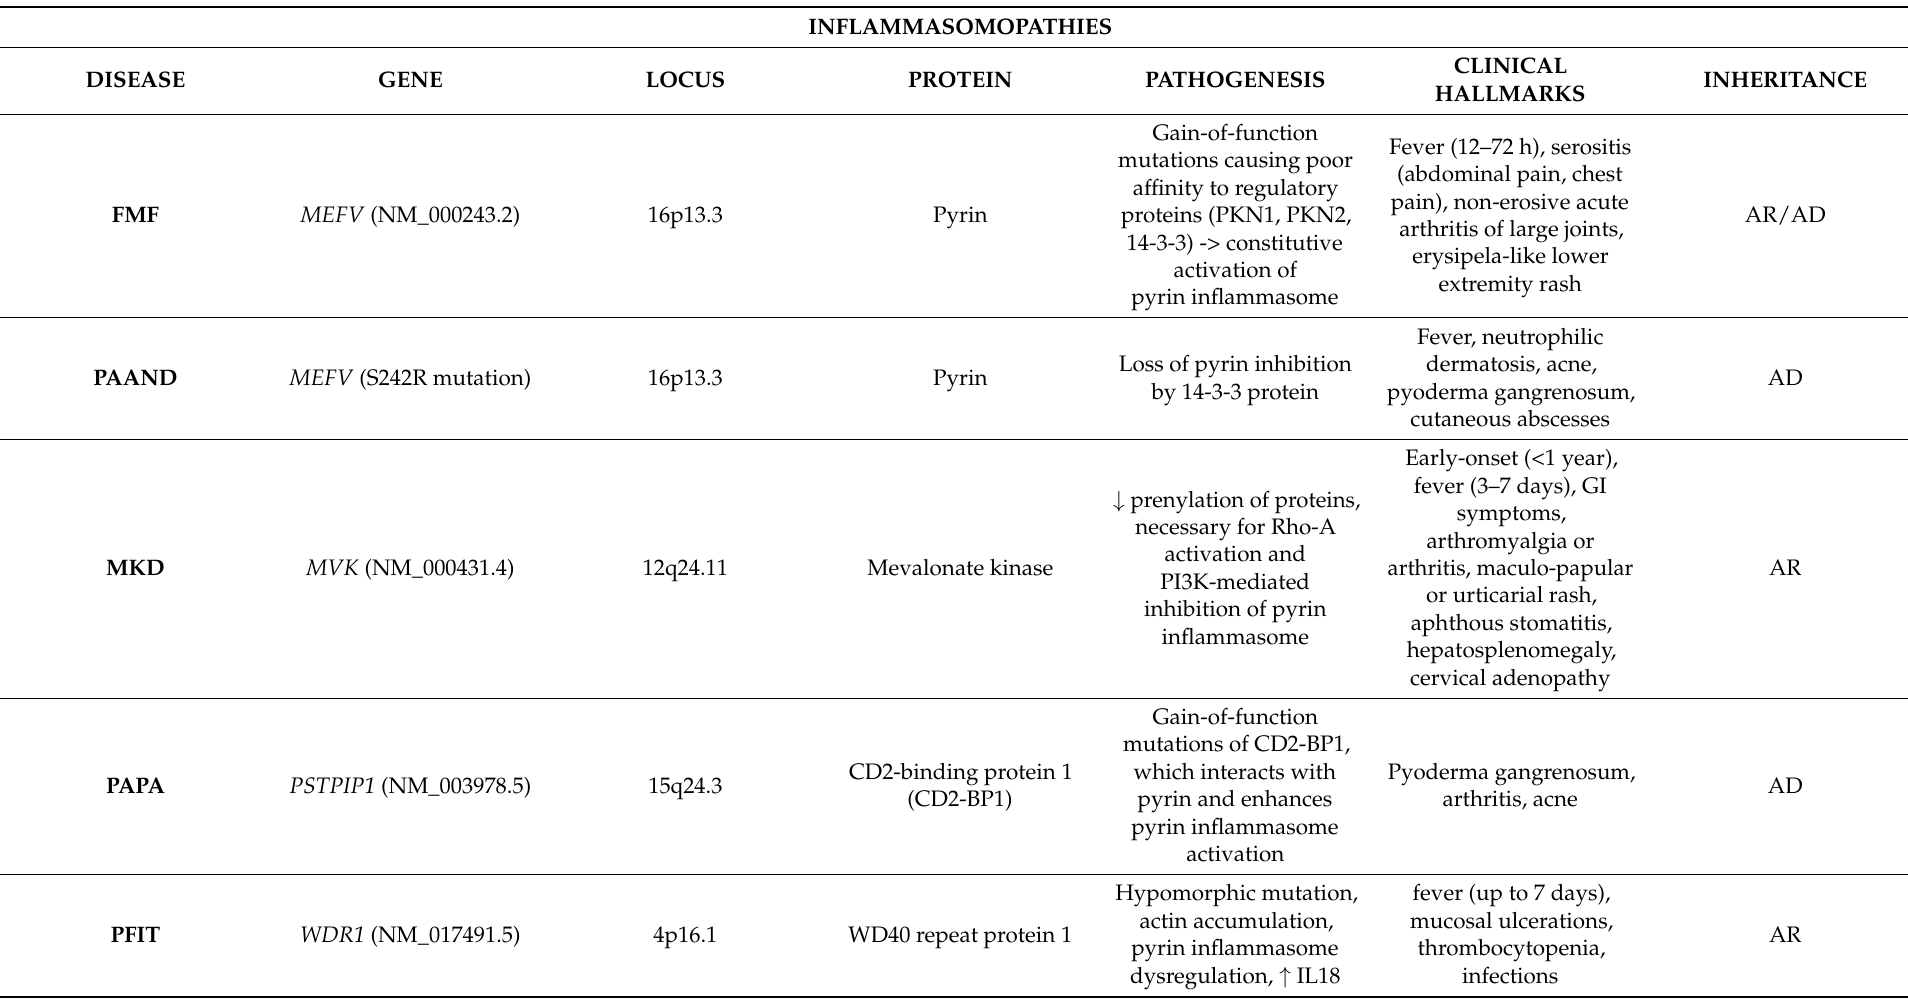
Table 1. Monogenic AIDs